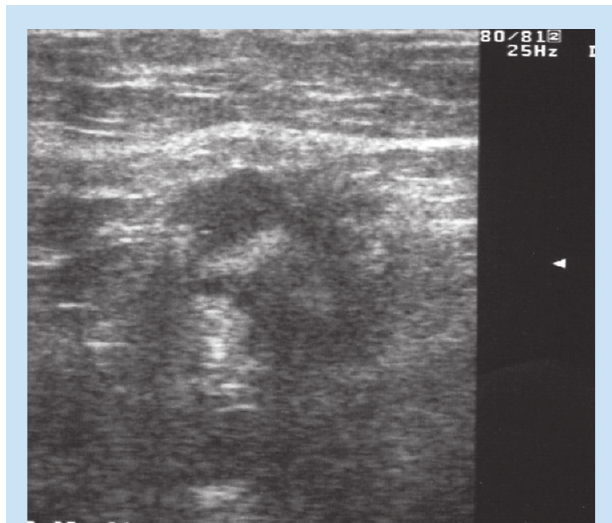
Fig. 3. Two axillary lymph nodes were also